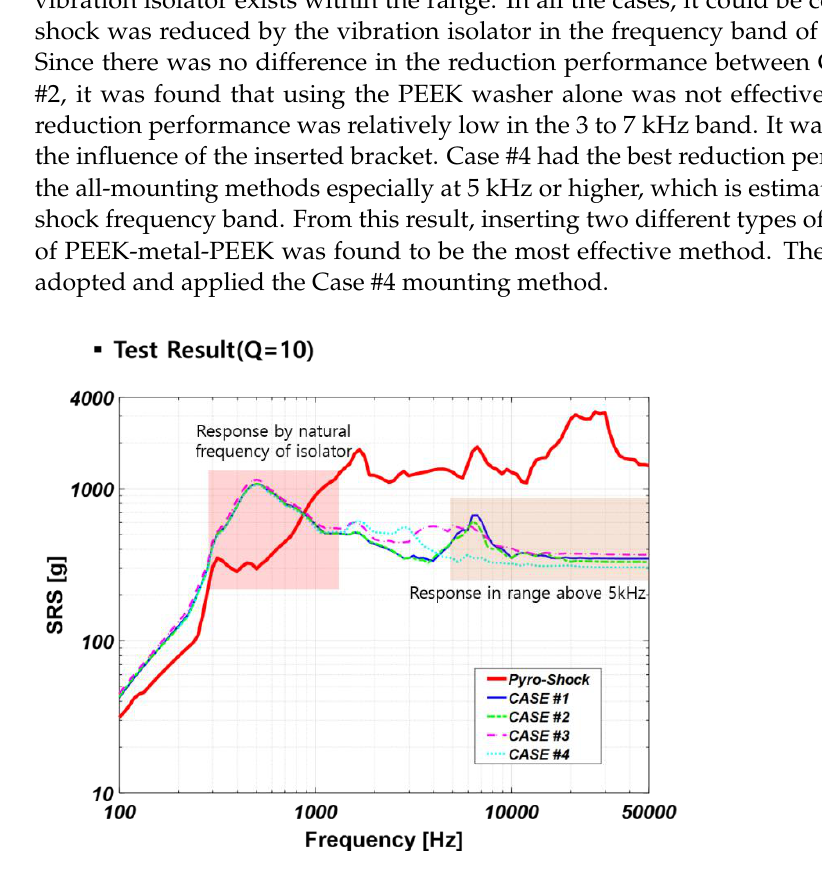
Figure 17. SRS result of pyro-shock simulation.